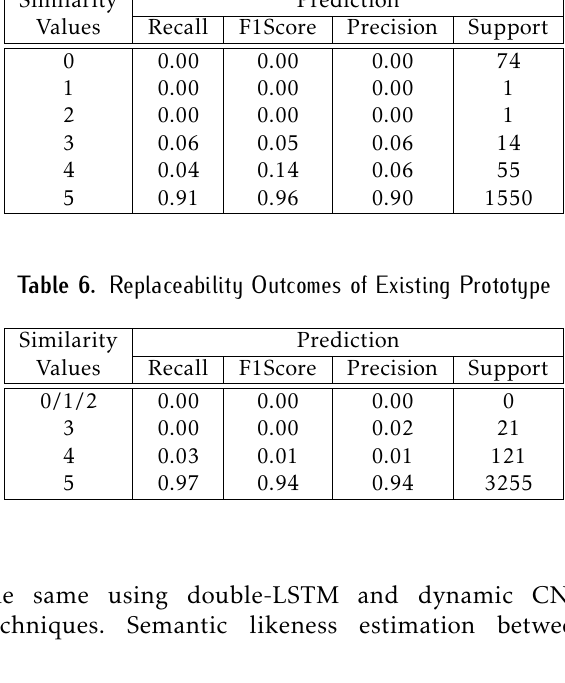
Table 5. Transitivity Outcomes of Existing Prototype Similarity